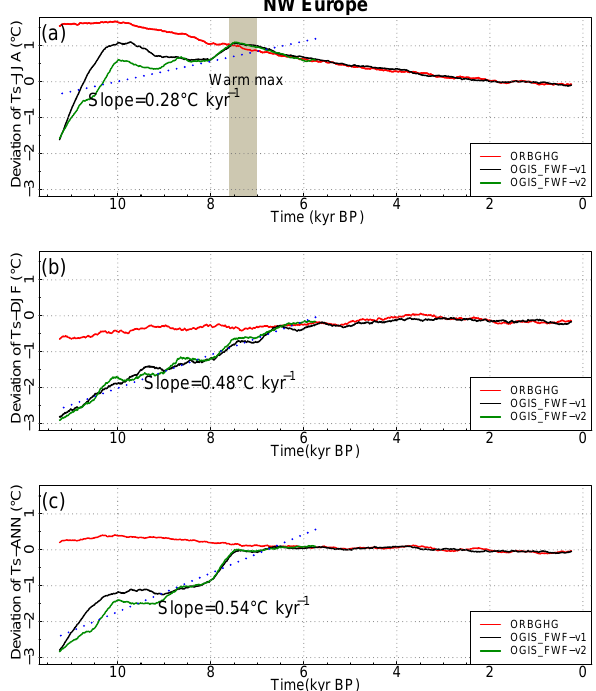
Figure 5. Same as Fig. 4 but for northwestern Europe (5 ◦ W–34 ◦ E, 58–69 ◦ N). mer and less than 0.5 ◦ C for annual mean, and rose by 0.5 ◦